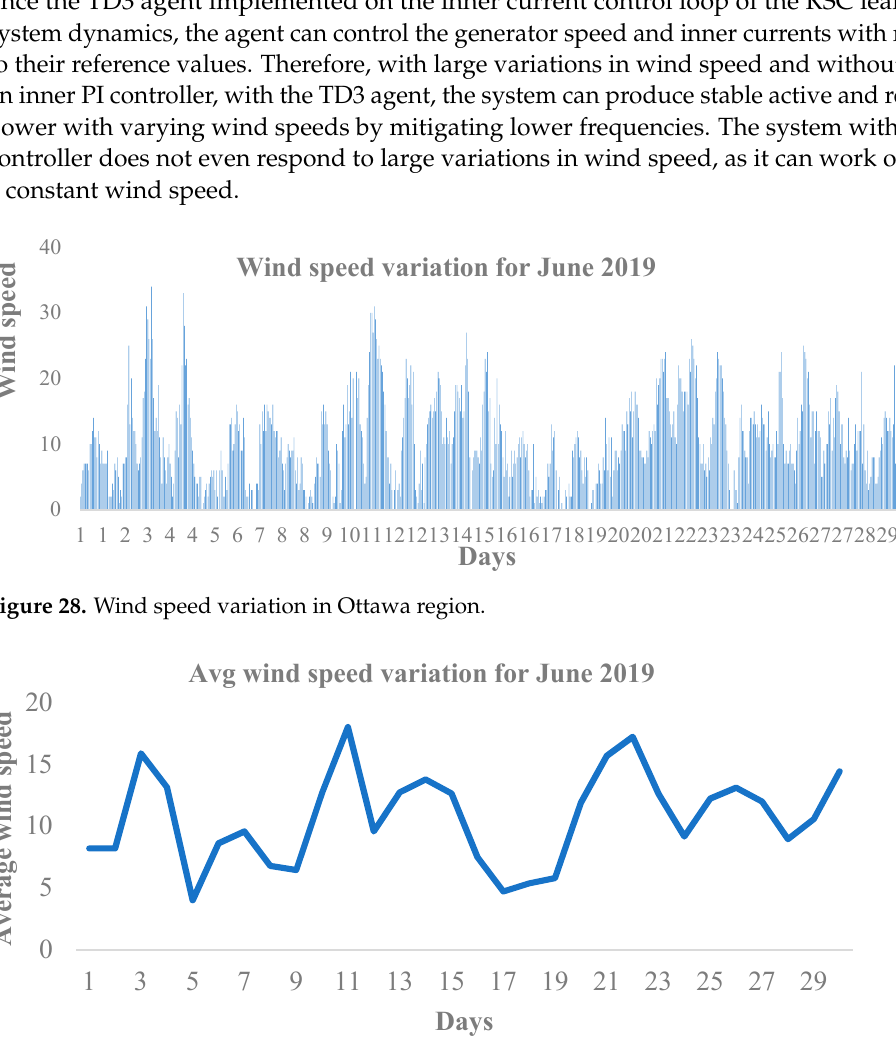
Figure 29. Average wind speed variation in Ottawa region.